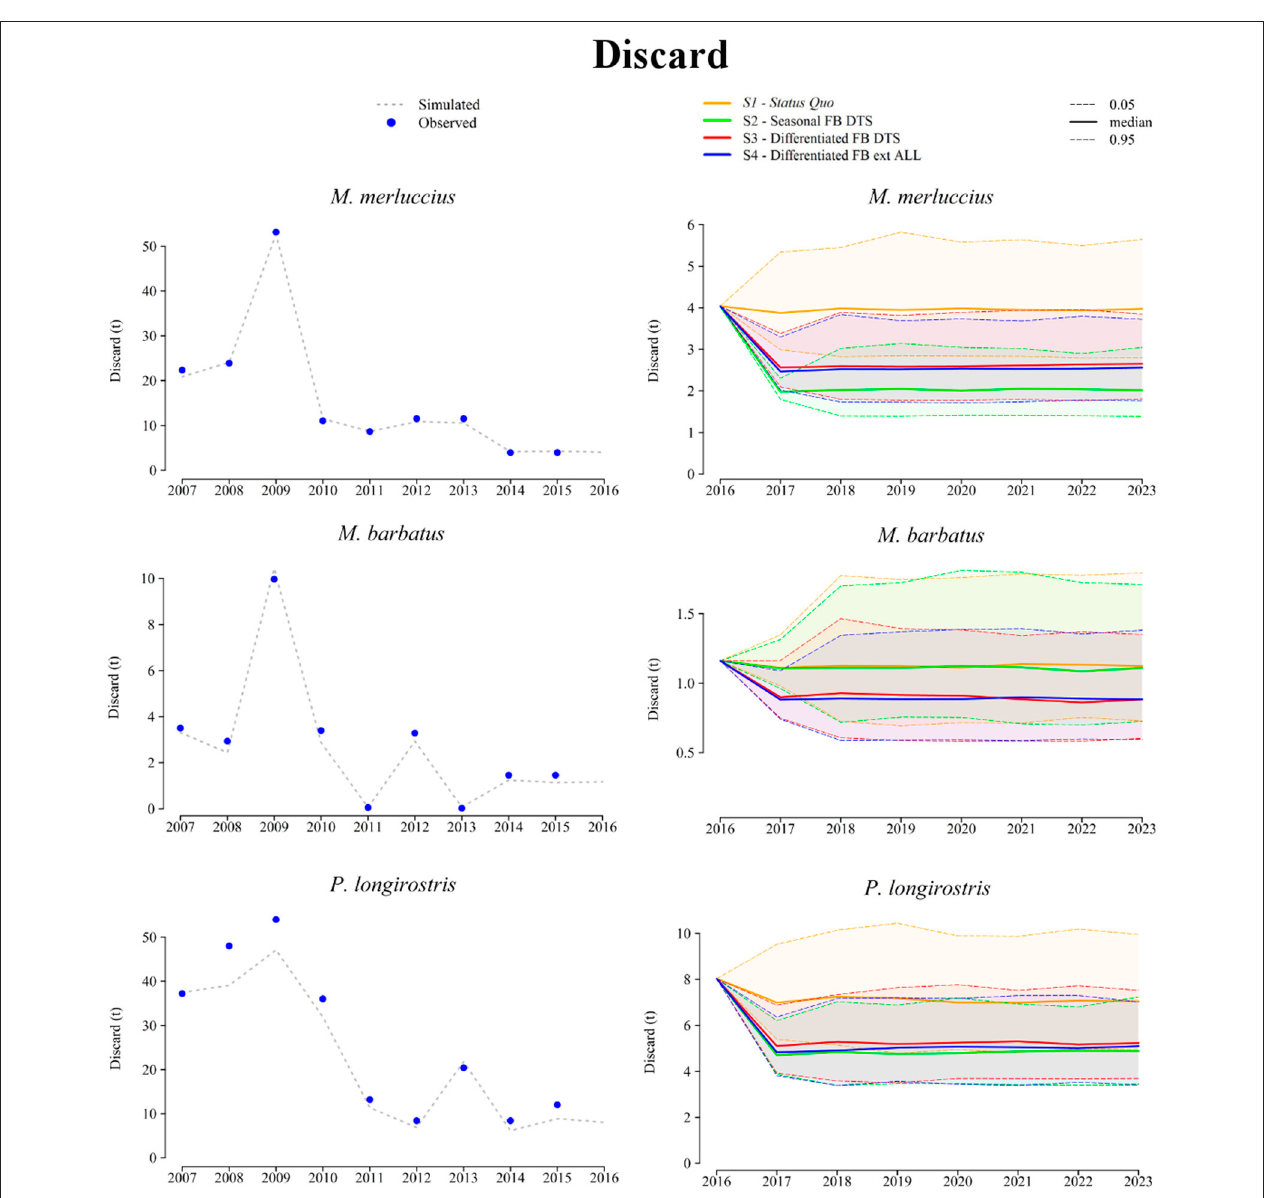
FIGURE 4 | Comparison among the scenarios of discards (trawlers) of European hake, red mullet, and deep-water rose shrimp in the hindcasting (2007–2016) and forecasting (2017–2023) timelines. Dotted line, Hindcasting from the bioeconomic modeling tool (BEMTOOL); Blue points, observed discard (DCF